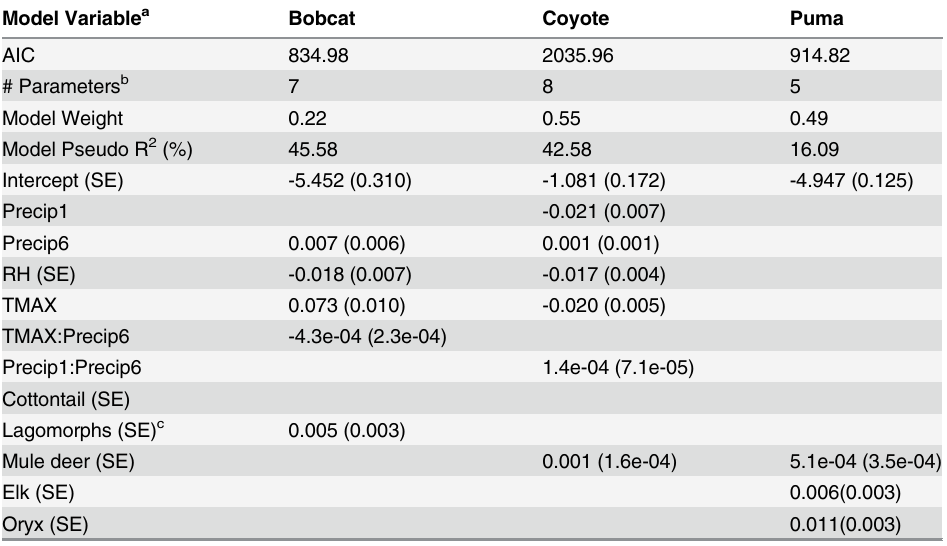
Table 3. Predator